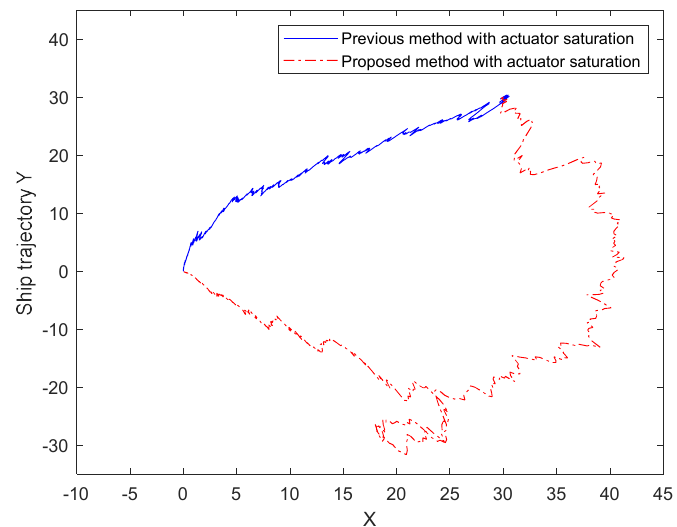
Figure 13. The trajectory of the ship with difference control method.